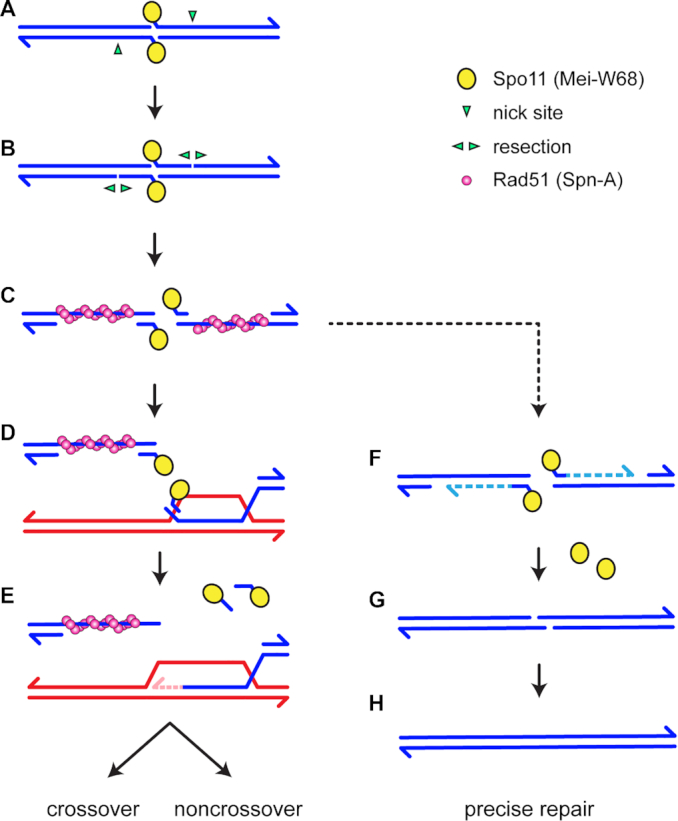
Models for Rad51-, Lig4-dependent meiotic DSB repair. See Supplementary Figure S1 for additional models. In the canonical model (left), DSB formation involves concerted nicking by two Spo11 proteins (yellow circles), which remain covalently bound to 2-nt 5′ overhangs through a tyrosyl phosphodiesterase bond (A). Resection is initiated by nicks (green arrowheads) 3′ of the DSB, then (B) extended bidirectionally (3). Rad51 and associated proteins (the meiosis-specific Rad51 paralog Dmc1 is not shown because it is not present in Drosophila) assembles on the single-stranded DNA exposed by resection (C). Recent observations suggest that a short Spo11-oligonucleotide remains annealed at the end of each 3′ overhanging strand (24,25). A homology search and strand exchange produces a D-loop (D). Removal of the Spo11-oligonucleotides, either by cleavage or dissociation, allows repair synthesis to proceed (E). Subsequent steps (not shown) produce crossover and noncrossovers. We hypothesize that if a homologous template cannot be found, such as in regions of heterosynapsis in Mcm5A7 mutants, the Spo11-oligonucleotides function as primers for fill-in synthesis (F). NHEJ can then complete repair through annealing of the 2-nt overhangs (G), resulting in precise repair (H).